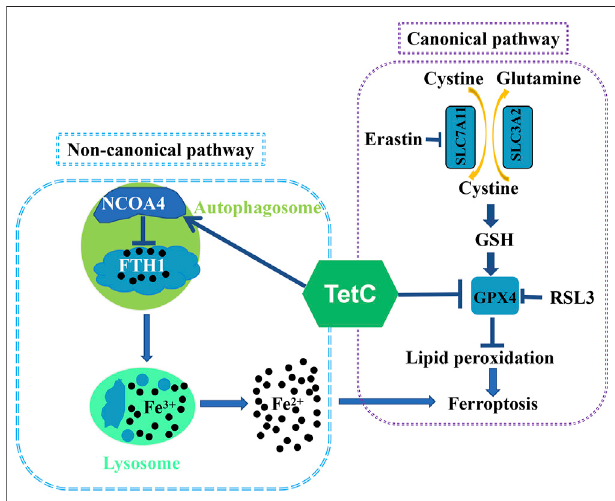
FIGURE 8 | Mechanism by which TetC suppresses ferroptosis in BC